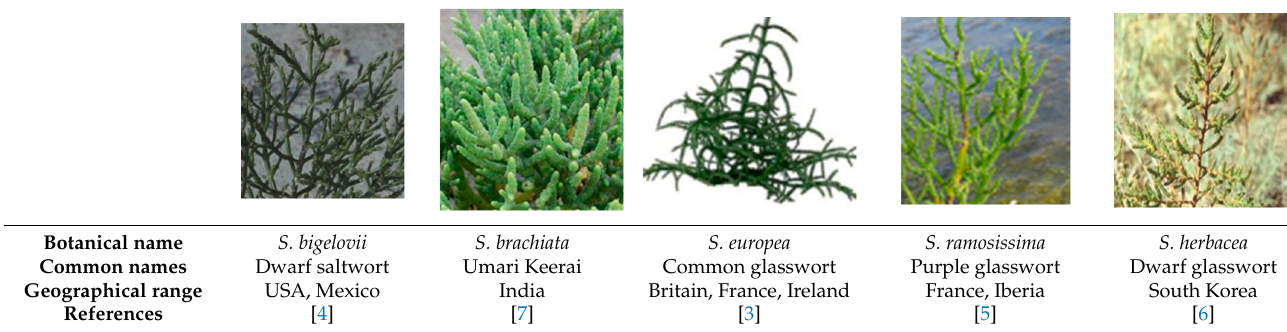
Table 1. Characteristics of the main Salicornia plants.